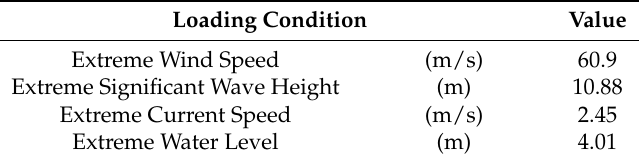
Table 5. Environmental data for Chang-Bin wind farm under the IEC DLC 6.2a loading condition.